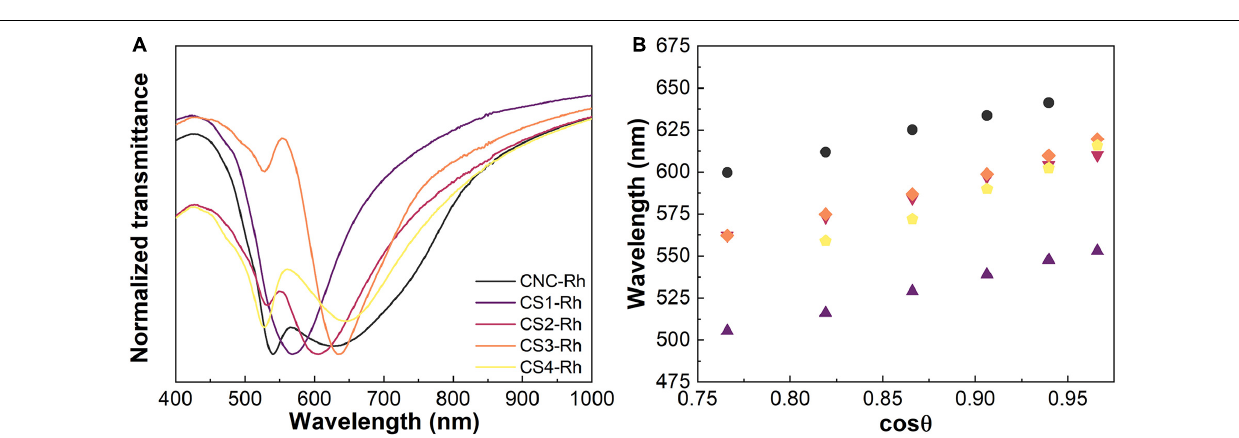
FIGURE 4 | Transmittance spectra of CNC, CS1-Rh, CS2-Rh, CS3-Rh, and CS4-Rh (A) . Variation of the peak position of the reflectance spectra as a function of the cos θ for the same CNC/silica composites doped with Rh6G (B)